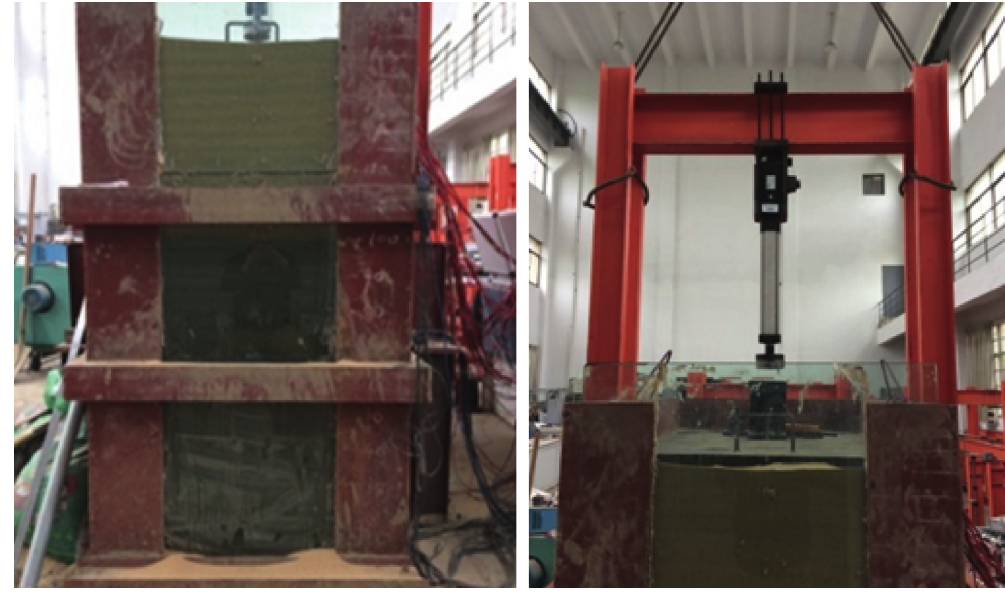
Figure 1: Test equipment used in the model test. Table 1: Physical and mechanical properties of silty and mucky